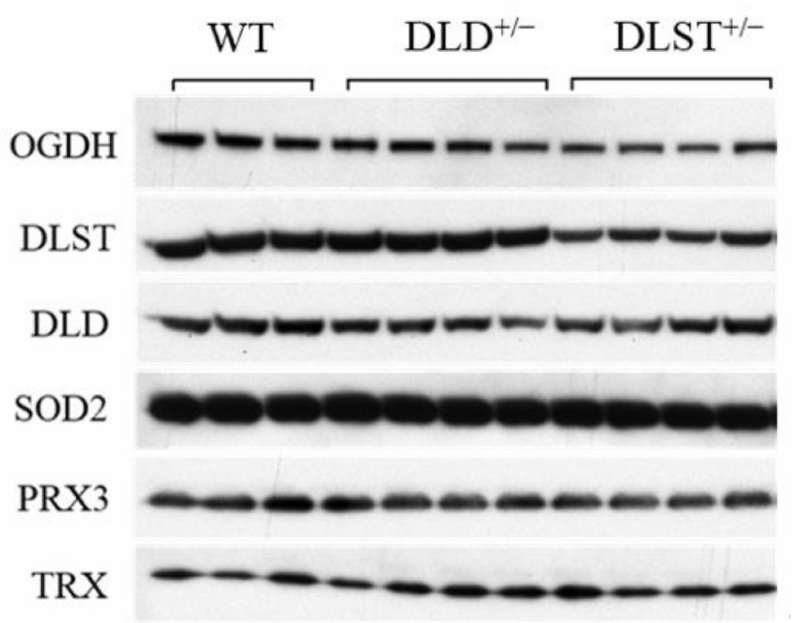
Figure 7. Immunoreactivities of alpha-ketoglutarate dehydrogenase (KGDH/OGDH), dihydrolipoyl succinyltransferase (DLST), dihydrolipoyl dehydrogenase (DLD), superoxide dismutase 2 (SOD2), peroxiredoxin 3 (PRX3), and thioredoxin (TRX) in mitochondria isolated from brains of wild-type (WT), DLST +/ − , and DLD +/ − transgenic mice.